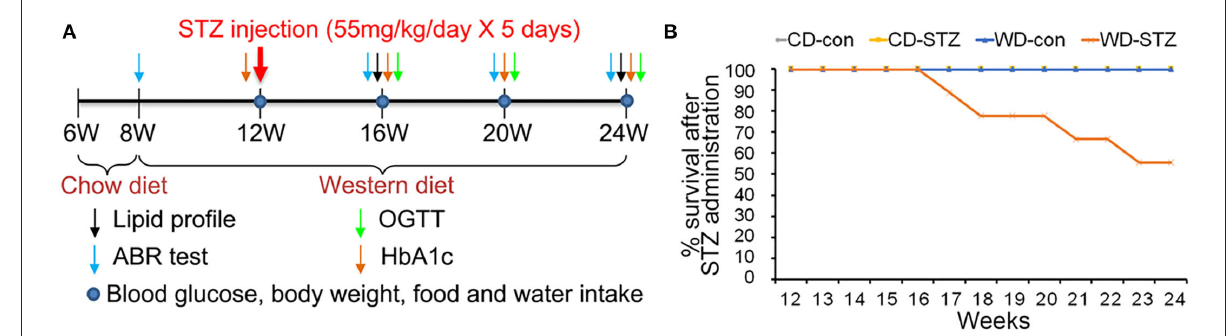
FIGURE1 Experimental protocol and survival rate. (A) Experimental protocol, including procedures and timeline, for each group. A western diet (WD) was provided at 8 weeks of age, and streptozotocin (STZ) was injected at 12 weeks of age to induce hyperlipidemia and hyperglycemia. (B) Decreased survival rate in the WD-STZ mice due to severe atherosclerosis and diabetes. The WD-STZ mice exhibit a gradual decrease in survival rate starting from 17 weeks of